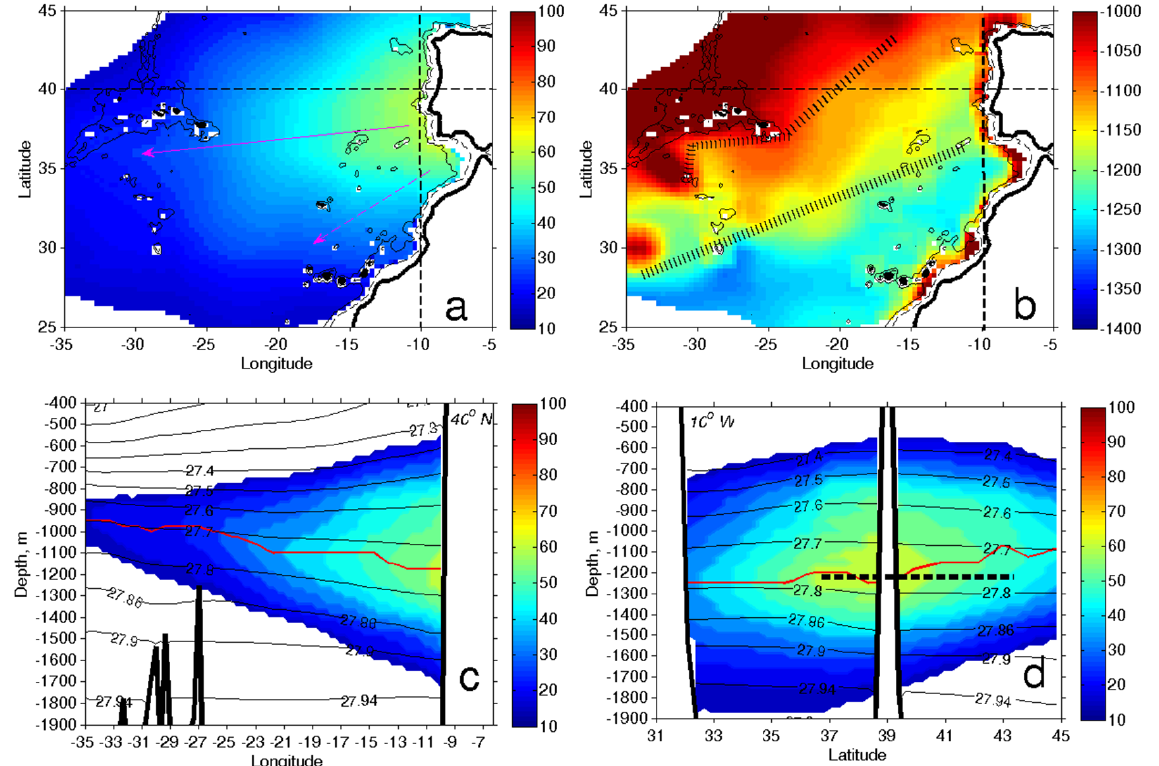
Figure 6. MW: (a) Maximum percentage in the water column, magenta lines mark suggested pathways of MW; solid line – main MW core, dashed line – lower MW core. (b) Depth (m) at which the maximum percentage in the water column is reached; the black dotted lines mark the maximum core-depth gradients. Isobaths of 500 and 2000m are marked in dashed and solid black lines, respectively. Zonal and meridional sections, presented in panels (c) and (d) , are marked with dashed black lines. (c) zonal section of MW content (%) along 40 ◦ N; (d) meridional section of MW content (%) along 10 ◦ W, (the topographic rise at 39 ◦ N is Estremadura Promontory). Solid black lines are neutral density surfaces. In panel (d) the black thick dashed line marks the limits of the meridional extension of the continental slope of the Iberian Peninsula to the east of the section. Red line marks the depth of the maximum content of the source water type in the water